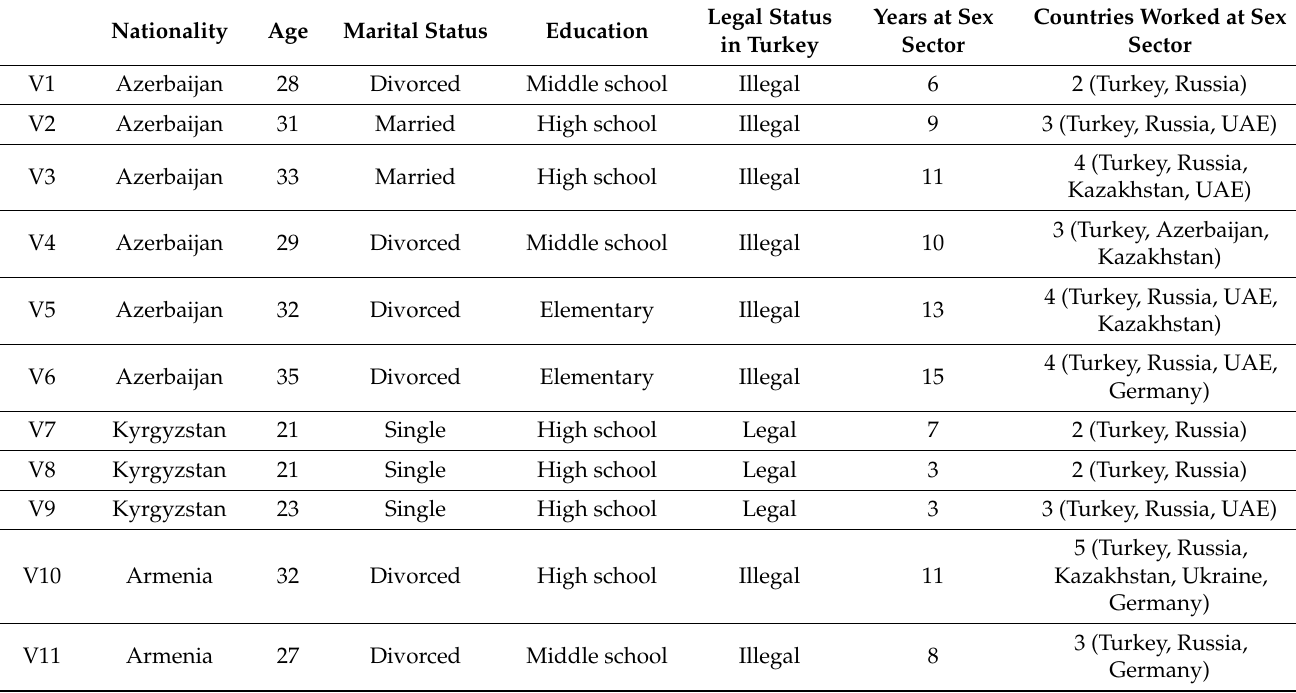
Table 2. Demographics of victims interviewed in this